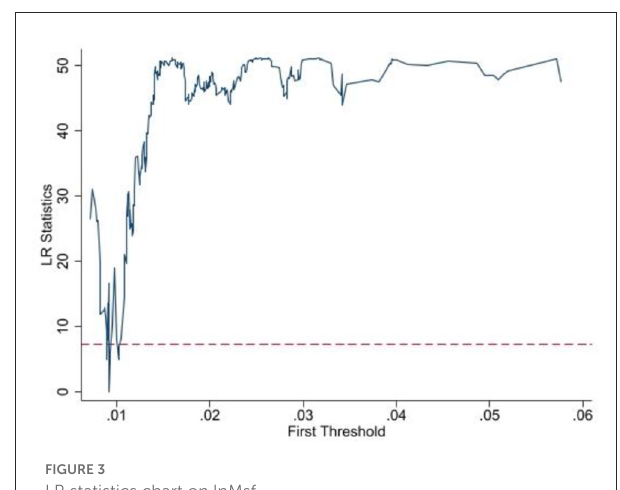
FIGURE2 LOWESS curve.